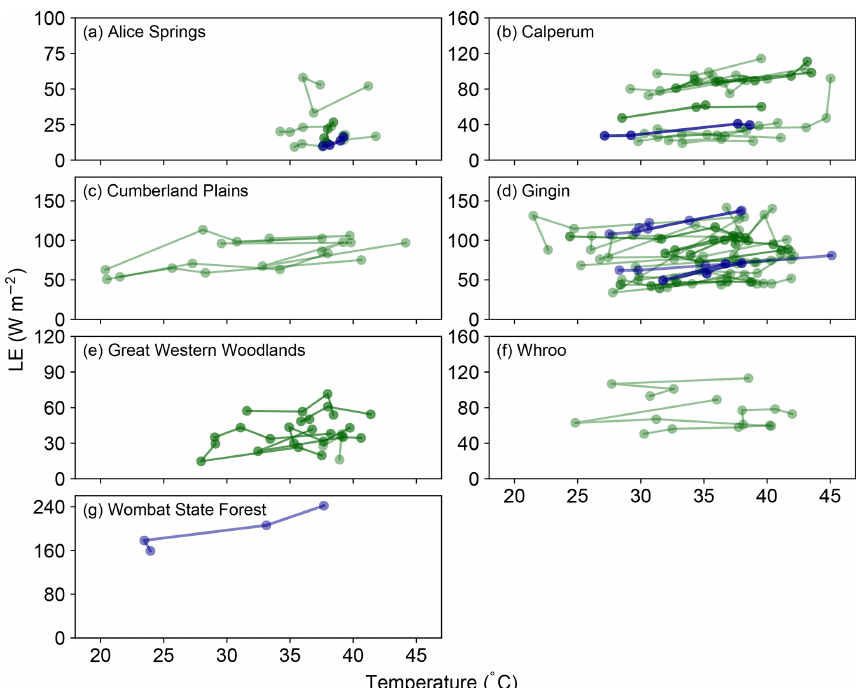
Figure 2. Evolution of LE in the 3 days prior to and including a hot temperature extreme (daily maximum temperature exceeded 37 ◦ C). Dark blue lines represent events in which a fitted linear regression indicated a significant positive slope, whilst dark green lines represent events where the fitted slope was positive but not significant. Note in both cases that we are not showing the fitted slopes, but we are simply using this approach to identify stronger positive or negative trends in these data (see Sect. 2). Events where the fitted slope was negative are shown in Fig.